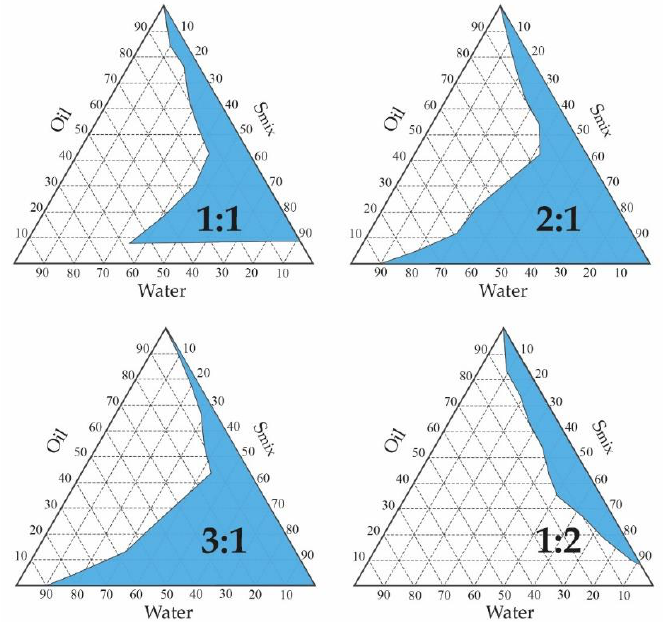
Figure 3. Pseudo-ternary phase diagrams using different ratios of surfactant/co-surfactants (S mix ) at 25°C.